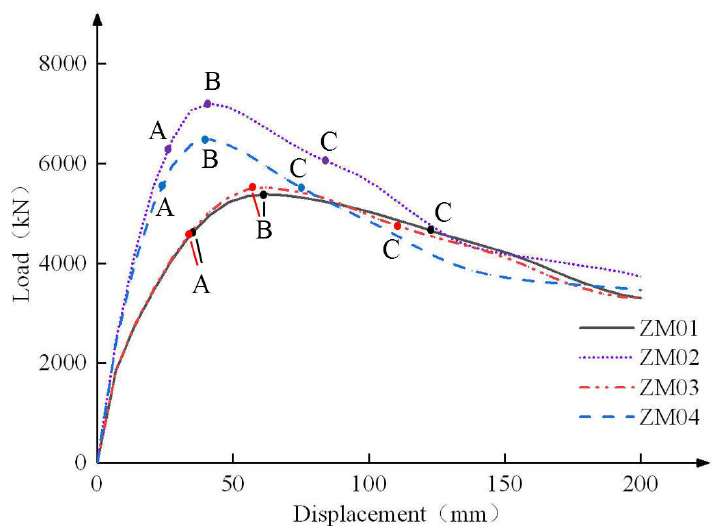
Figure 11. FE load–displacement curves for specimens ZM01–ZM04. Note: Point A is yield point, Point B is ultimate point, and Point C is failure point.